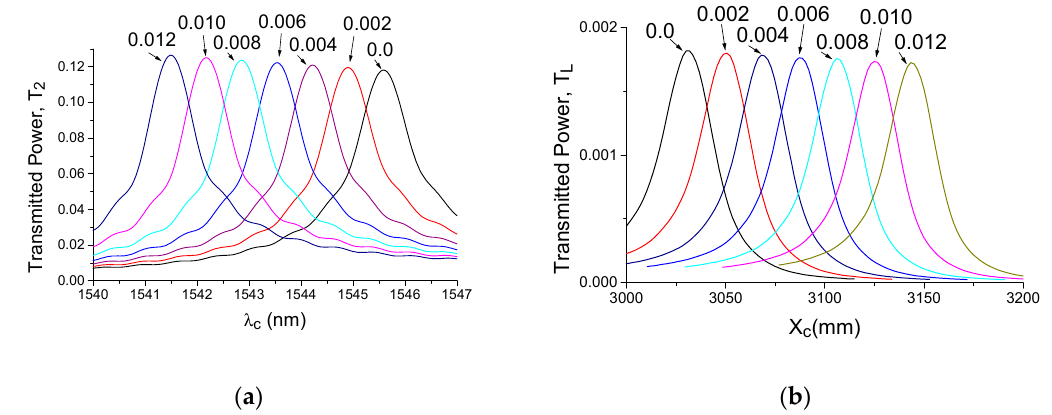
Figure 2. Simulated characteristics of the optical sensors and different index variations dn c of the environment (water). ( a ) Transmitting power (T 2 ) relative to the input signal of the leaky wave propagated in segmented grating; ( b ) the total power (T L ) distribution (as a sum of 100 different wavelengths) in the focal plane of the ideal lens with 10 mm focal length. Simulation by the two-dimensional (2D) finite difference time domain (FDTD) under the dispersion compensated the effective index method approximation, which included the linear transformation of the coordinates (2) and (3). 0.0161537153815391540154115421543154415451546